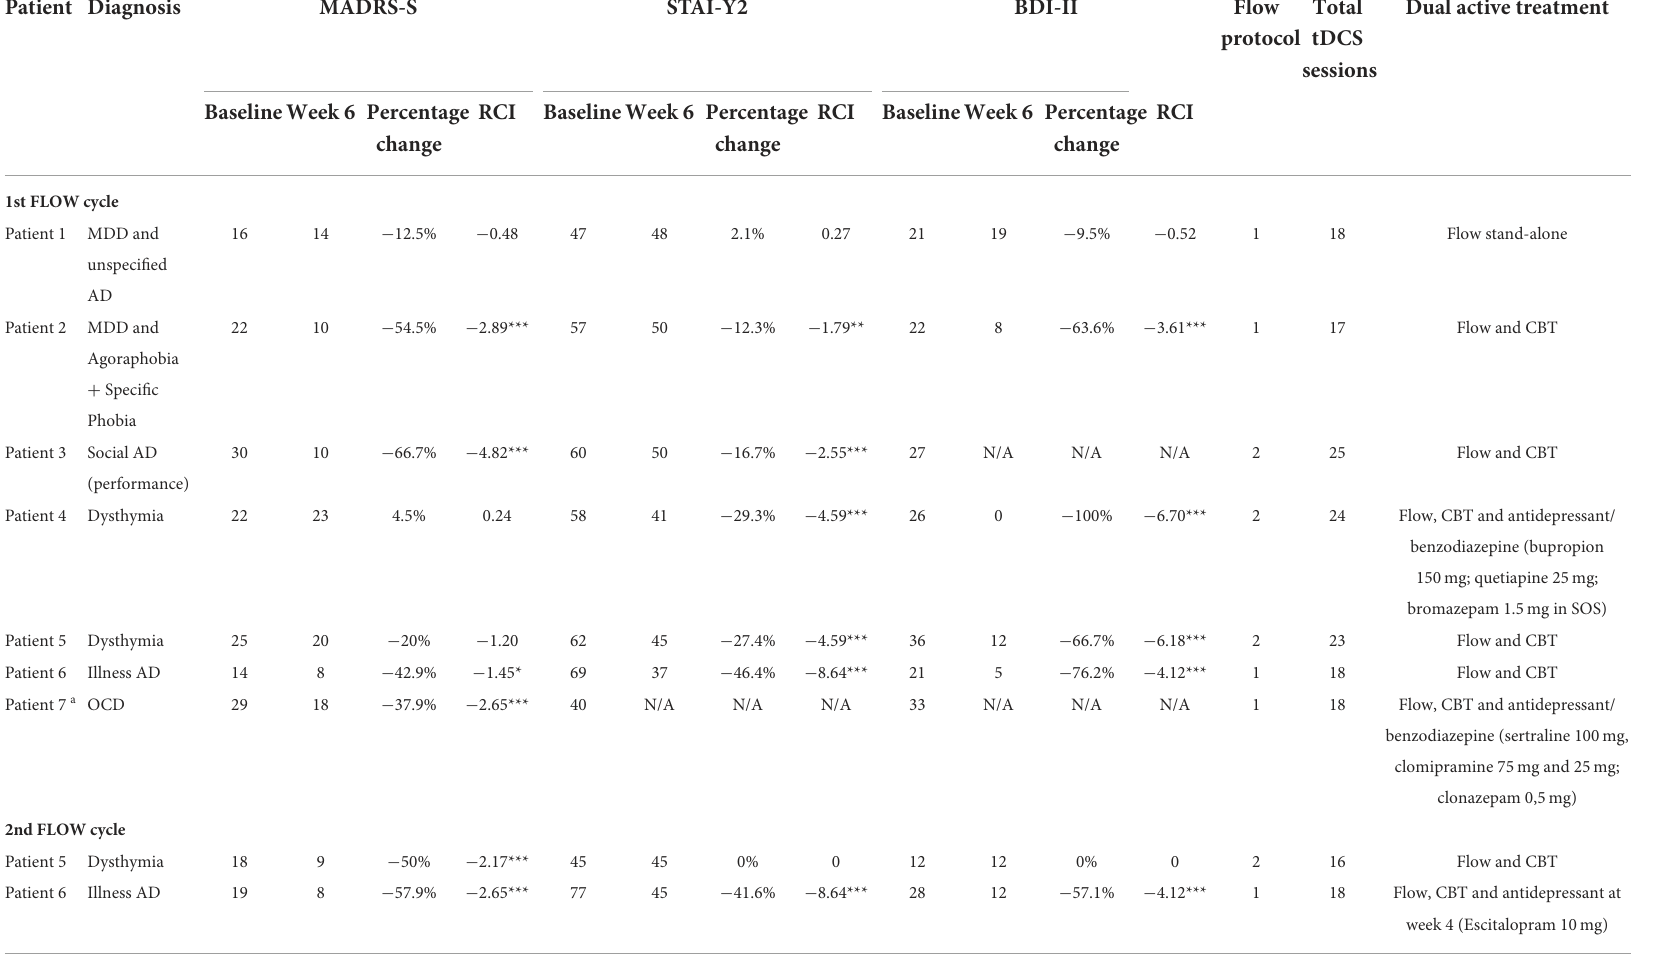
TABLE 2 Clinical findings before and after 6 weeks of